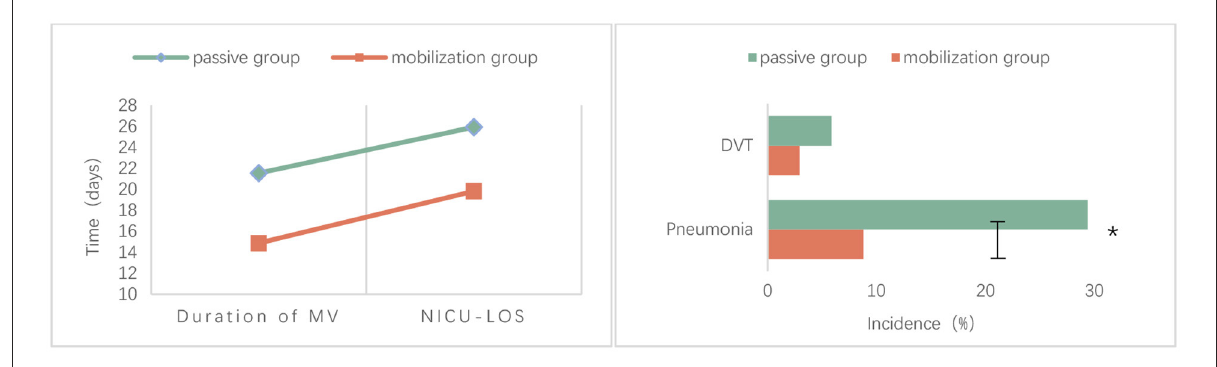
FIGURE2 Comparison of validity between the two groups; *mean p <